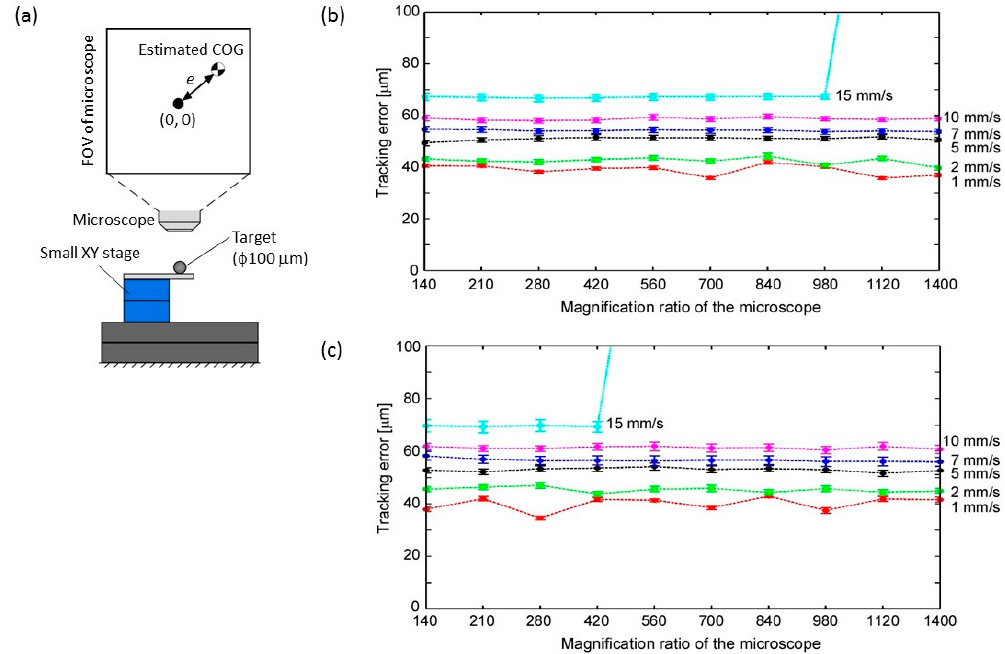
Figure 7. Tracking performance evaluation of developed platform. ( a ) Experimental setup; ( b ) Tracking error with typical image processing method; and, ( c ) Tracking error with implemented image processing method.